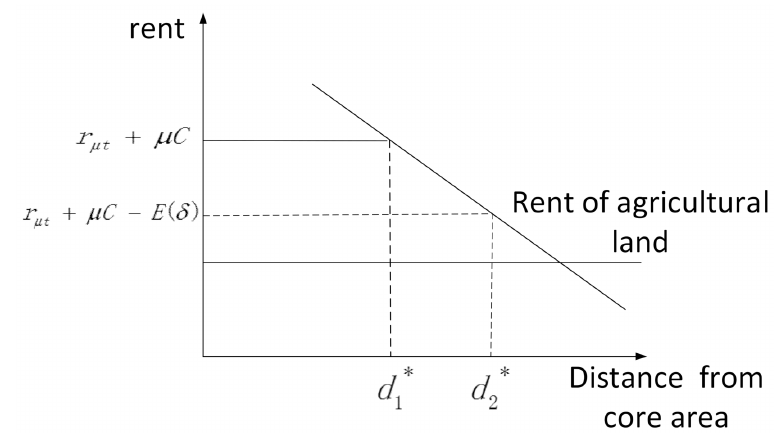
Figure 2. Diagram of urban space